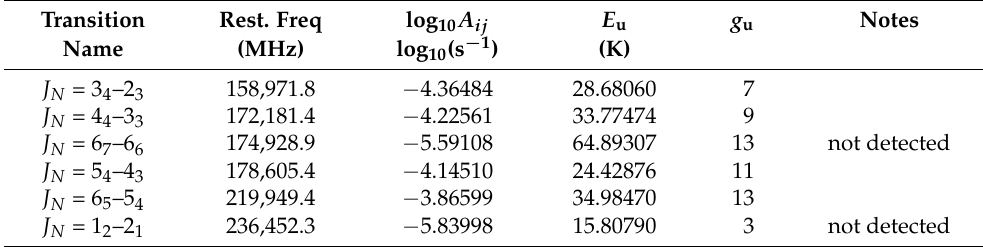
Table 1. Main parameters of the observed SO